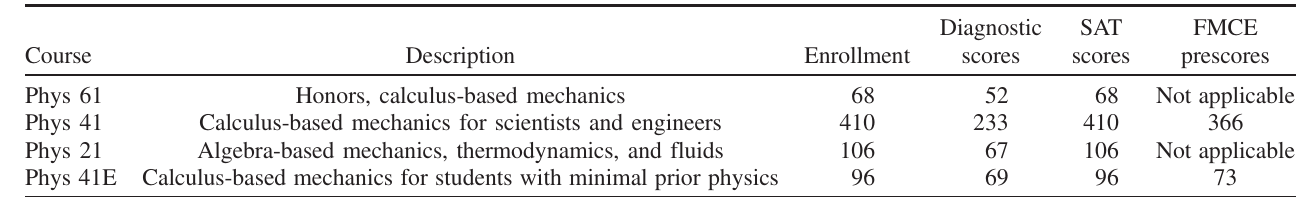
TABLE I. Descriptions of all introductory mechanics courses offered at Stanford, their 2019-2020 enrollment, and how many students for whom we had (i) diagnostic scores, (ii) SAT or ACT math scores, and (iii) FMCE